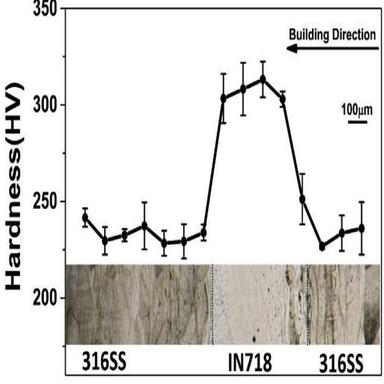
The microhardness profile across the 316SS/IN718 sample.